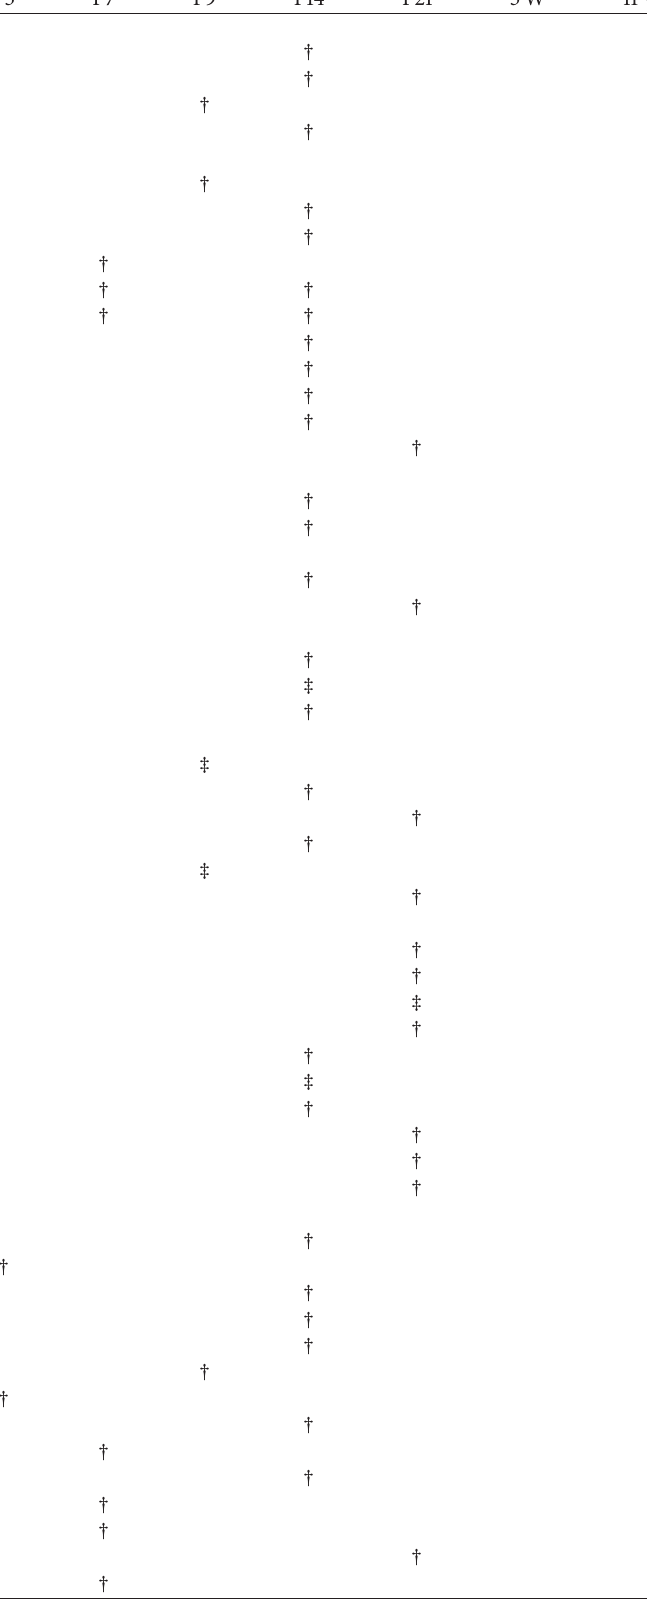
Table 1: The beginning periods of PNN formation in the developing brain. “ † ” indicates the periods that immature PNNs could be first detected. Asterisks ( ∗ ) indicate brain regions not having typical PNN forms and “ ‡ ” in these regions indicates the period that WFA signals were first detected. “¶” in the bottom rows shows known critical periods and their references in brackets. P3 P7 P9 P14 P21 5W